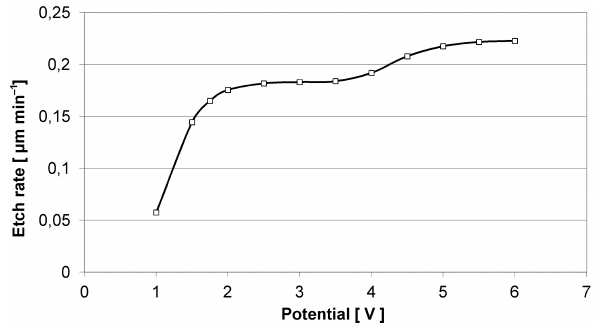
Figure 2. Potential-dependent etch rate at 2s pulse time in 30m% KOH(aq) at 60 ◦